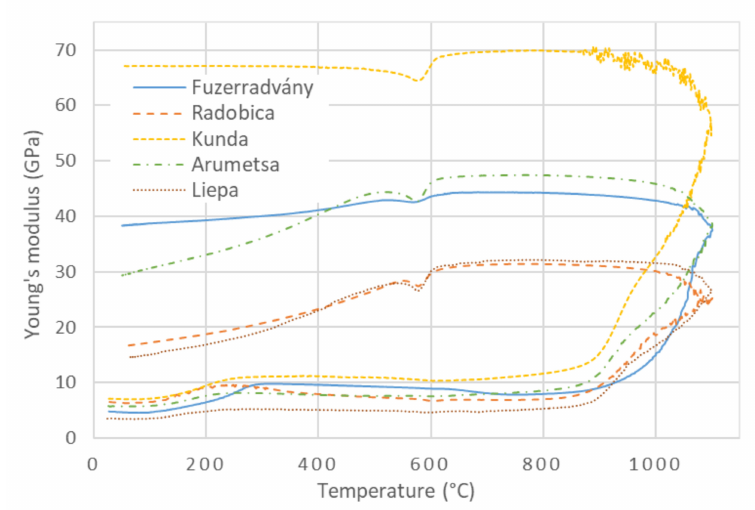
Figure 4. Young’s modulus of investigated clays.